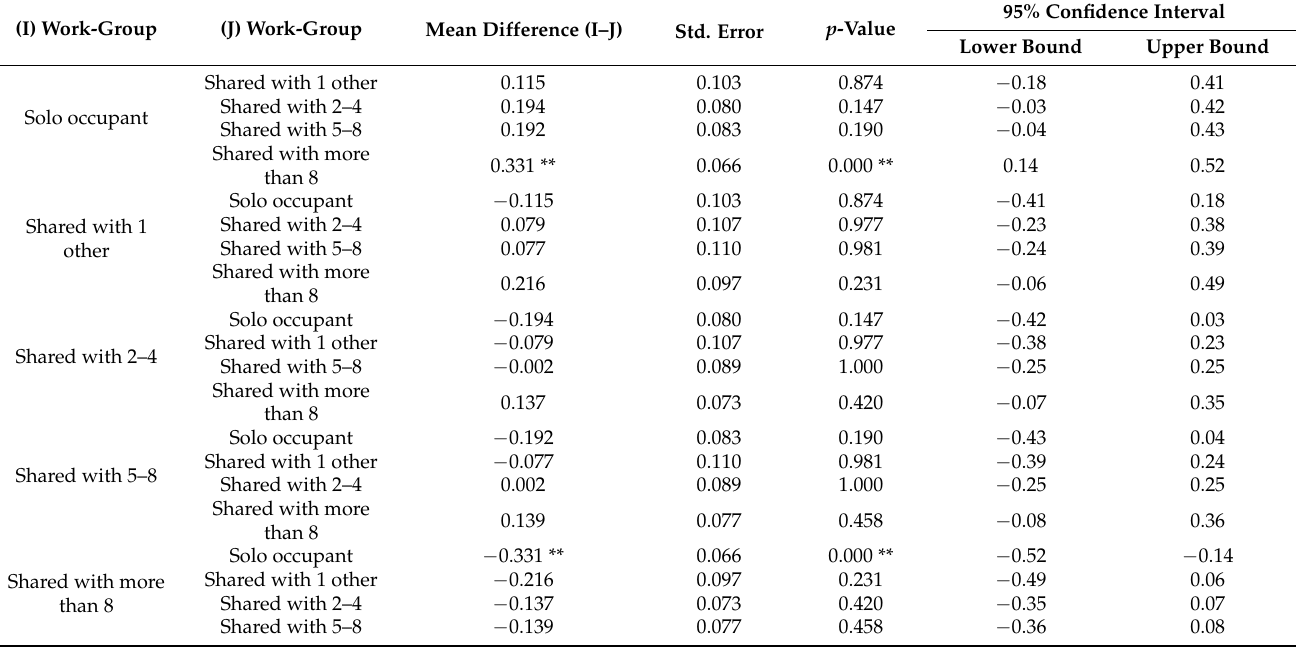
Table 18. Multiple comparisons and Tukey honestly significant difference (HSD) analysis for productivity scores among different workgroups.